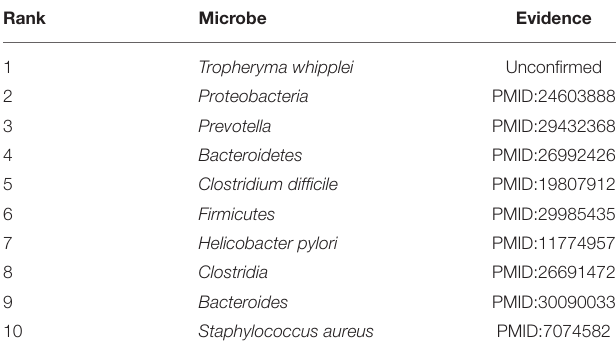
TABLE 5 | Top 10 potential CRC-related microbes predicted by BWNMHMDA and 9 out of these 10 microbes have been confirmed by evidences. Rank